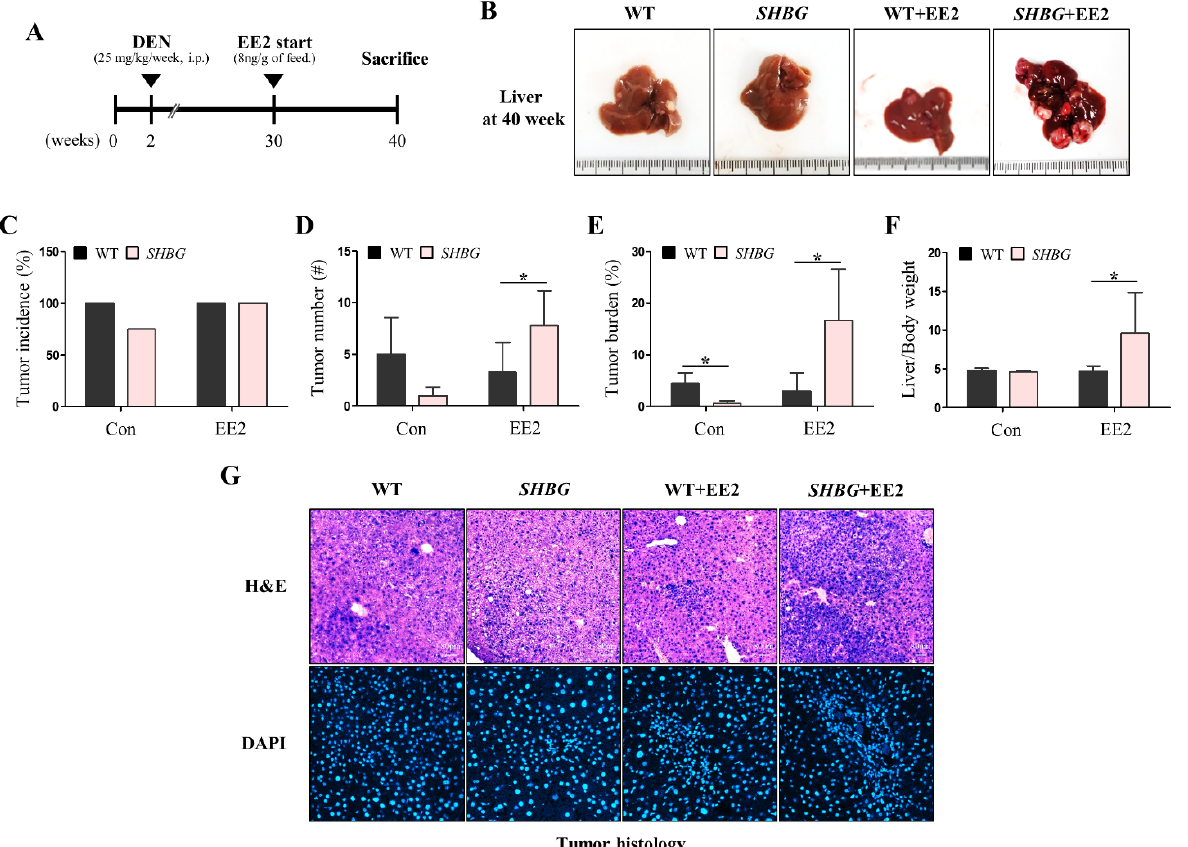
Figure 1. HCC development of EE2-fed WT and SHBG mice. ( A ) Experimental schedule for inducing HCC and feeding EE2. DEN (25 mg/kg, IP) was injected to 2-week-old mice. EE2 was dissolved in diet and fed to mice from the age of 30-weeks-old. Mice were sacrificed at 40-weeks of age. ( B ) Representative liver images of WT, SHBG , WT EE2, SHBG EE2 mice. ( C ) Tumor incidence of WT, SHBG , WT EE2, SHBG EE2 mice. ( D ) Tumor number of WT, SHBG , WT EE2, SHBG EE2 mice. Each tumor numbers were counted per liver. ( E ) Tumor burden of WT, SHBG , WT EE2, SHBG EE2 mice. Each tumor burden per liver was calculated from ratio of the tumor area per total liver area. Image J software was used for an analysis. ( F ) Liver per body weight of WT, SHBG, WT EE2, SHBG EE2 mice. ( G ) Hematoxylin & Eosin (H&E) and DAPI staining in tumor-bearing livers of WT, SHBG, WT EE2, SHBG EE2 mice. Scale bar; 80 µm. Numbers of mice used for experiments were: WT (4), SHBG (4), WT EE2 (8), SHBG EE2 (8). Student’s t -Test was used for analysis. Values represent means ± SD. * p < 0.05.